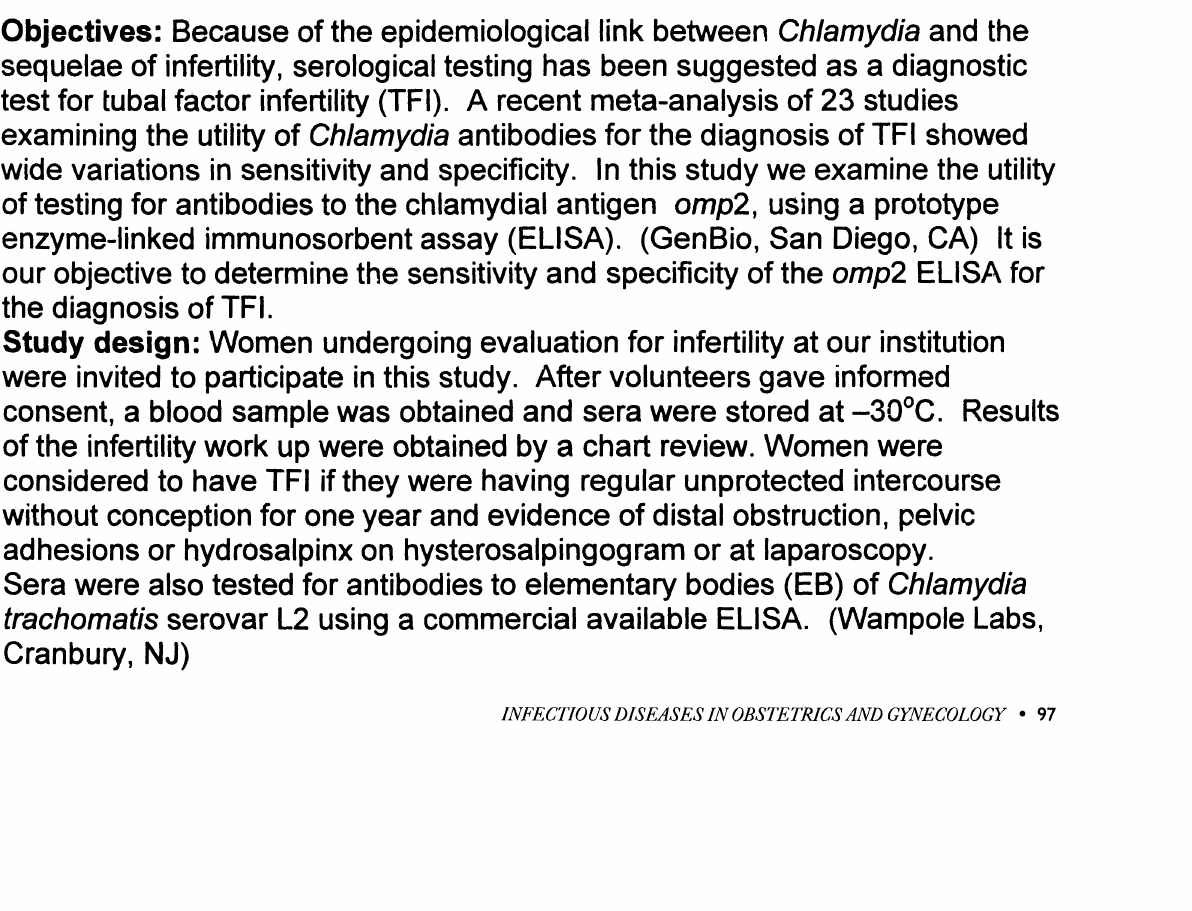
of stay, total antibiotic cost (including laboratory costs), and cost for treatment failure. Results: The clinical outcome of initial treatment with A/G/C revealed 100% success; conversely, the patients initially treated with Ticarcillin/clavulinate revealed a 75% successful treatment rate. The average daily antibiotic cost for A/G/C and Ticarcillin/clavulinate regimins were $294.99 and $157.32, respectively. The total cost of treatment with the two antibiotic options were determined through an Activity Based Costing approach and are presented in following table.